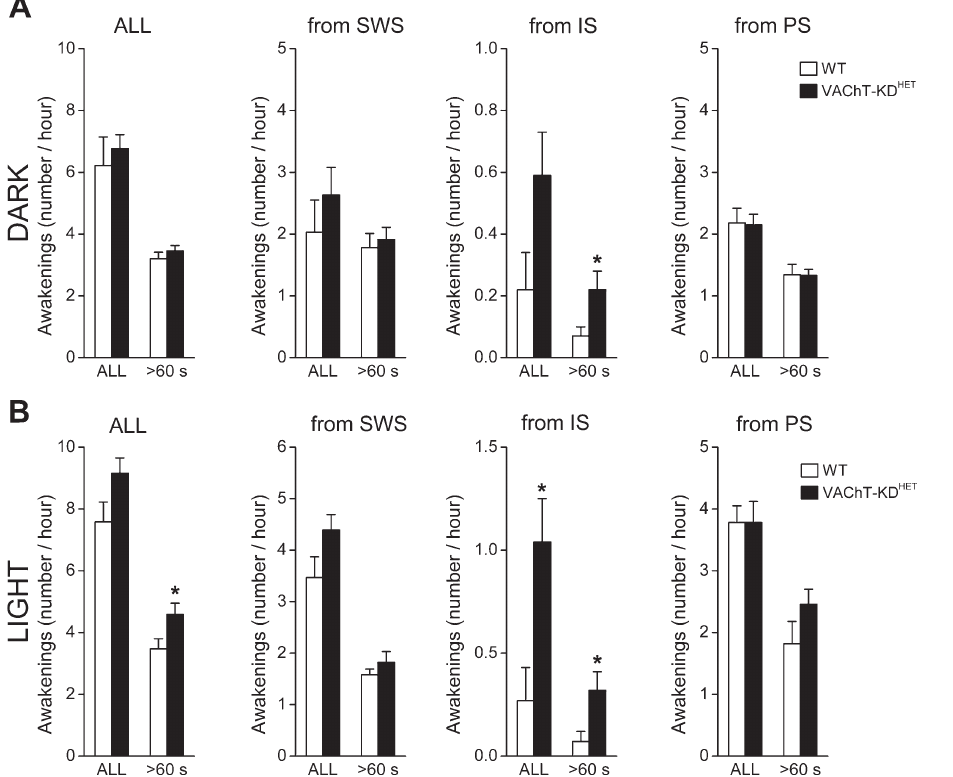
Figure 4. Awakenings during the dark ( A ) and light ( B ) phases. Data are reported as means±SE of the averaged number of awakenings in each 12-h period, separately from each sleep state. WT: wild-type mice (n=7); VAChT-KD HET : vesicular acetylcholine transporter knockdown heterozygous mice (n=7); SWS: slow-wave sleep; IS: intermediate sleep; PS: paradoxical sleep. *P , 0.05, compared to WT (Student t